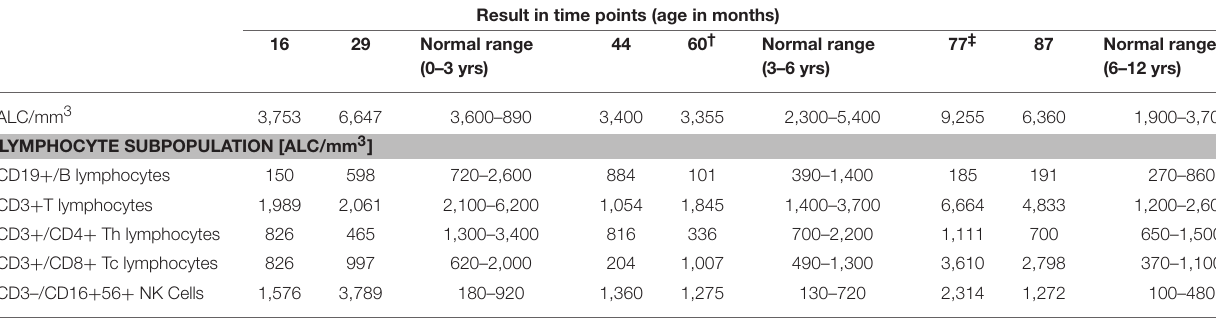
TABLE 3 | Immune profile of the SCID patient from the time of diagnosis up to the age of 7 years*. Result in time points (age in months)